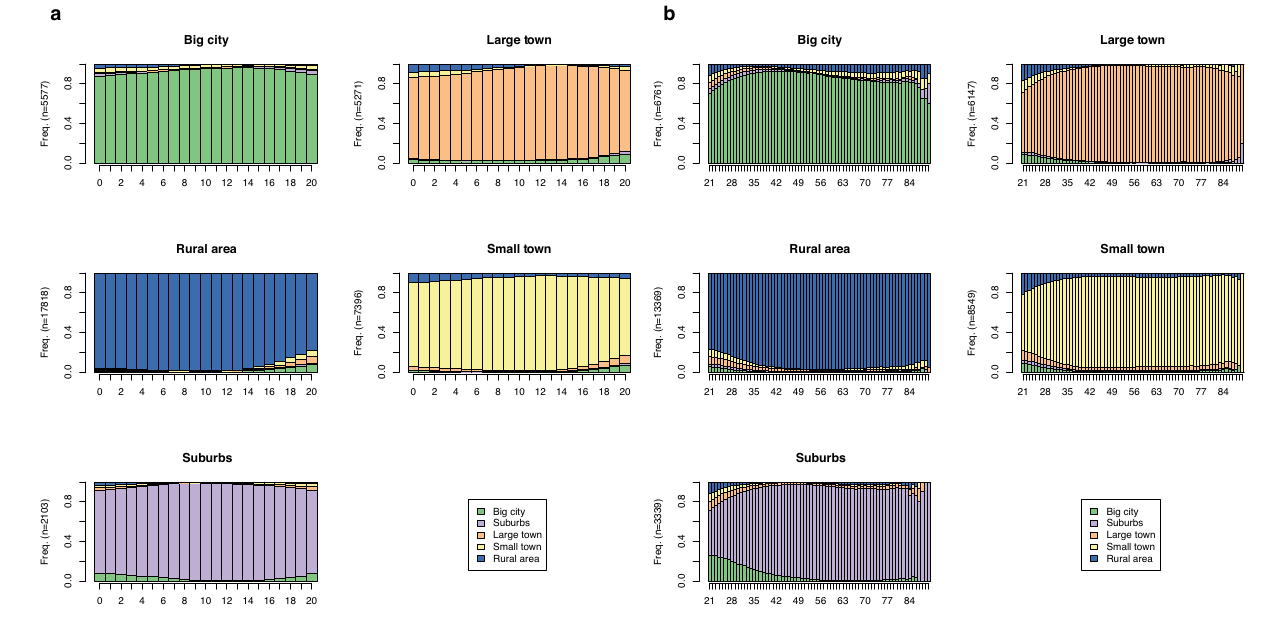
Figure 1. Sequence density plots for the five clusters of early-life residential trajectories ( a ) and midlife residential trajectories ( b ). For each cluster, the bars represent the proportion of respondents living in one of the five residential areas at a specific